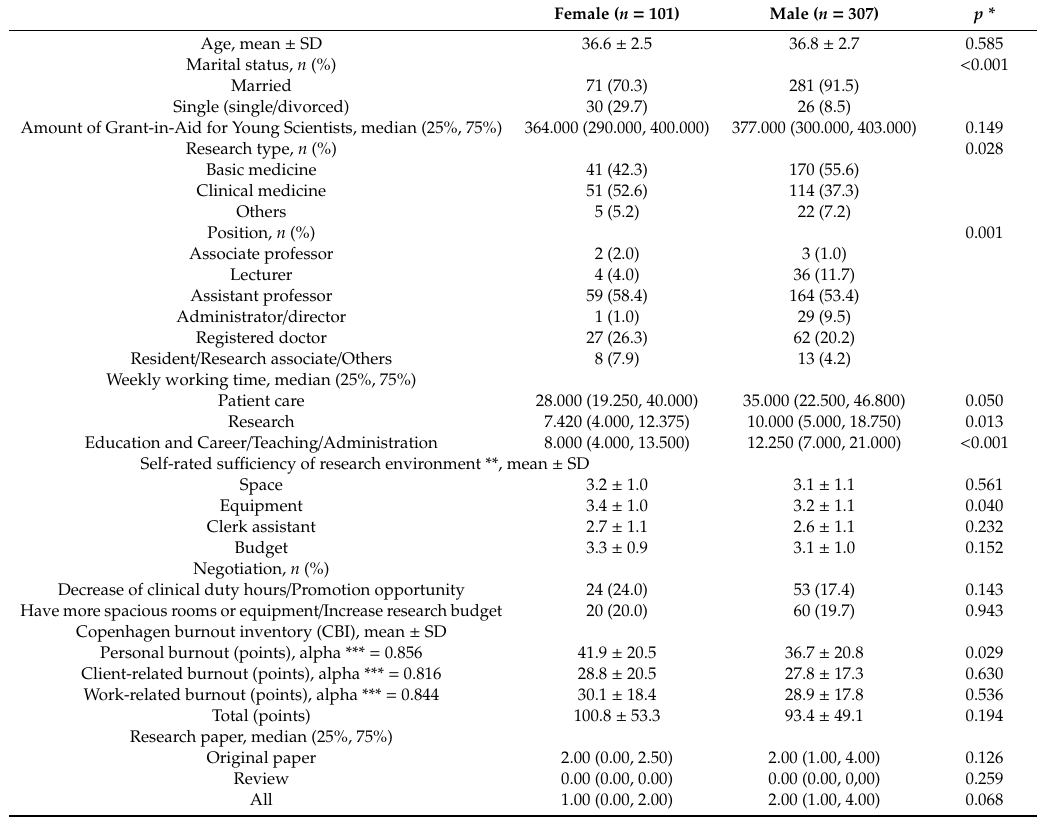
Table 1. Characteristics of Grant-in-Aid for Scientific Research (KAKENHI) awarded young physician researchers in